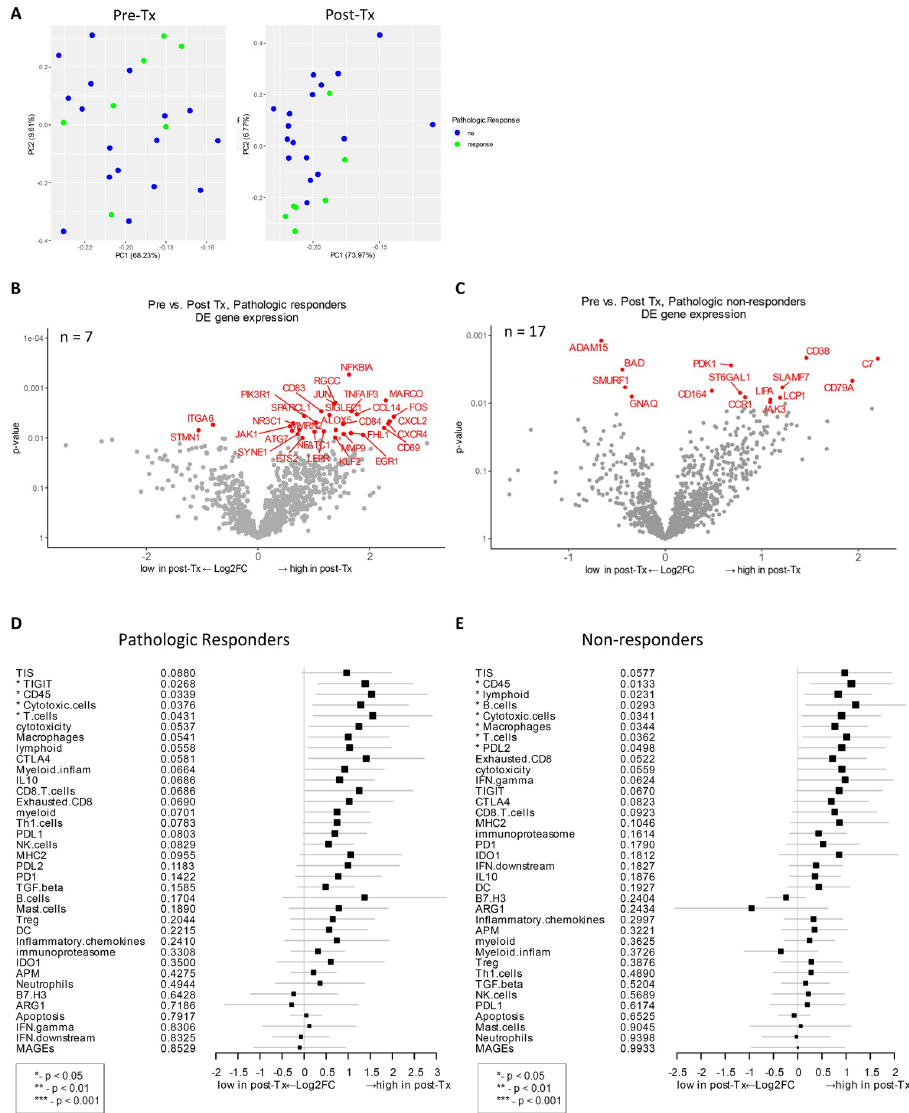
Fig 5. Post-treatment gene expression changes that correlate with pathologic response. A ) Principal component analysis was performed to look for distinct gene expression patterns in baseline vs. post-treatment samples. B ) Volcano plot of unadjusted p -value vs. log2-fold change of the differential expression after treatment, which associate with pathologic response (unadjusted p < 0.01). This analysis only includes data from 7 patients (n = 7) who exhibited pathologic response and for whom both baseline and post-treatment samples were available C ) Analysis as as in Fig 5B, but only includes data from 17 patients (n = 17) who did not exhibit pathologic response and for whom both baseline and post-treatment samples were available (unadjusted p < 0.01). D and E ) Forest plot of difference of gene signature scores post-treatment in pathologic responders ( D ) and non-responders ( E ). The position of the squared dots denotes the difference of score, and the size denotes the statistical significance. The horizontal lines are the Wald-type confidence intervals. The � sign denotes the significance of p -value ( < 0.05 � ).